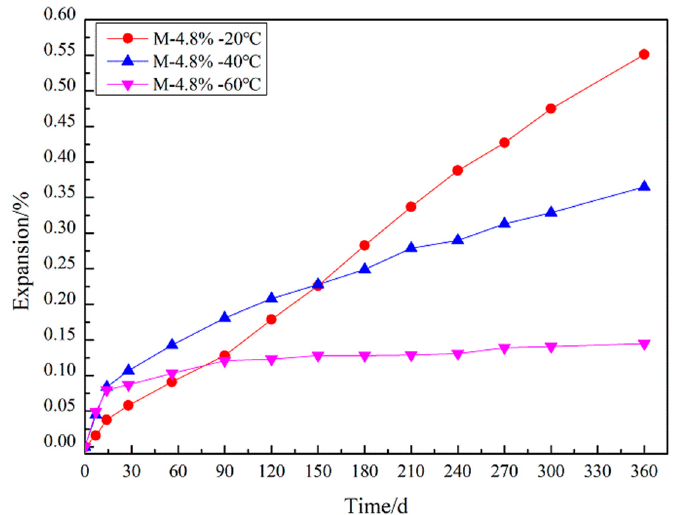
Figure 11. Expansion of mortars added with 4.8% SO 3 at different curing temperature.